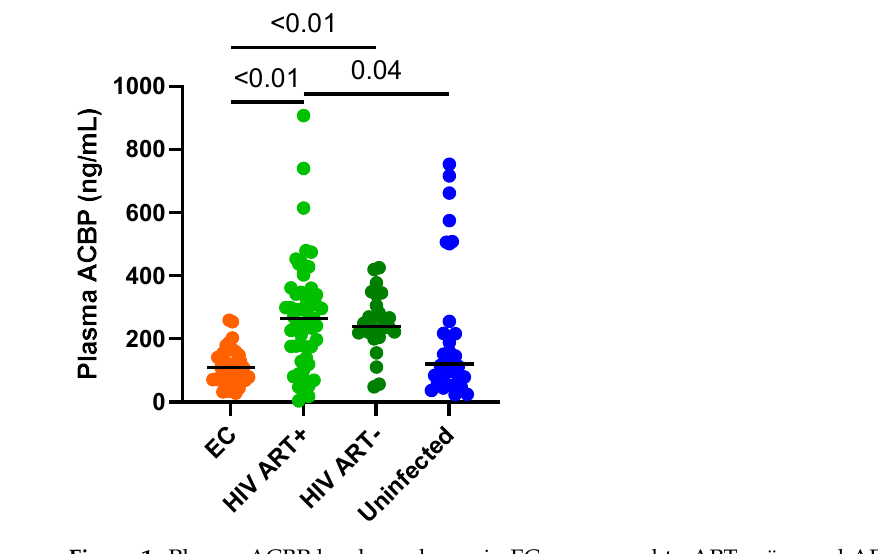
Figure 1. Plasma ACBP levels are lower in ECs compared to ART-naïve and ART-treated PLWH. Statistical significance measured via Kruskal–Wallis’s test. Black bars represent medians.